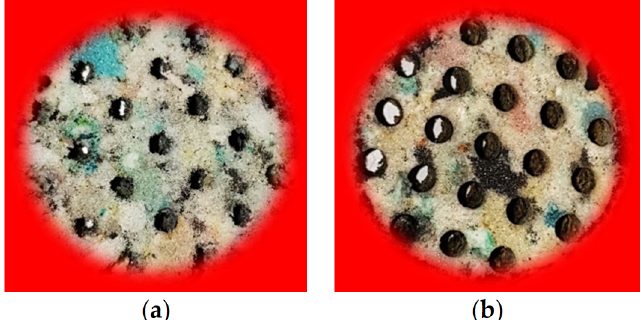
Figure 3. Specification of drilled RPU foams: D = 6 mm and ∅ M = 20%. ( a ) milling machine method; ( b ) laser method.